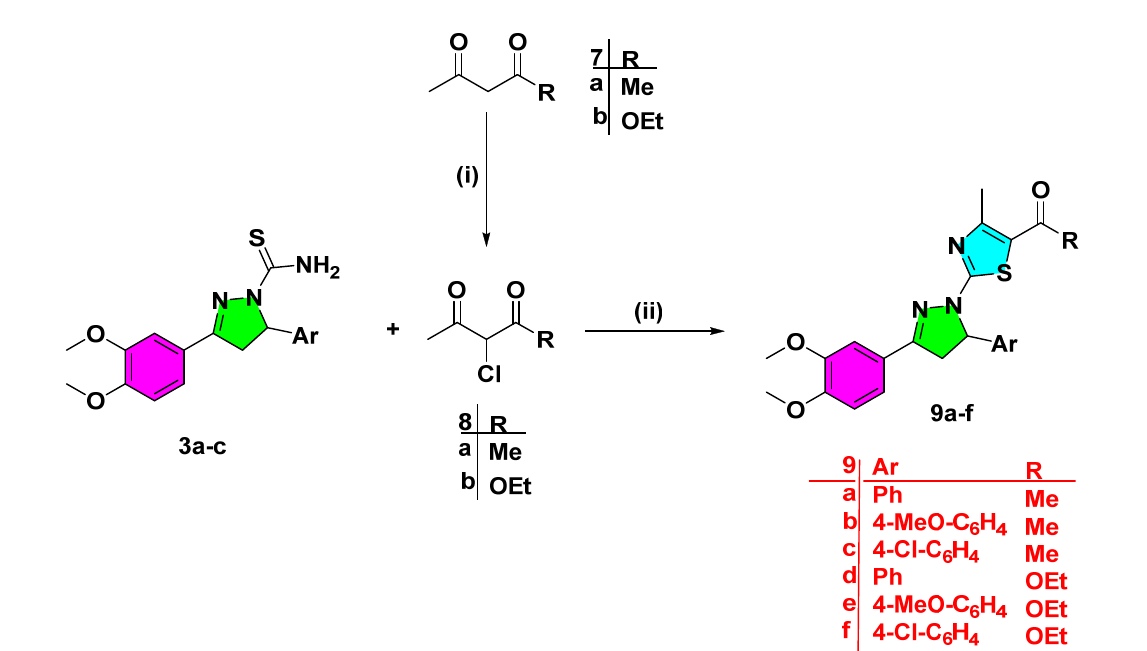
Chart 3. Synthetic pathway for obtaining compounds 9a-f . Reagents and conditions : i. Sulphuryl chlo-